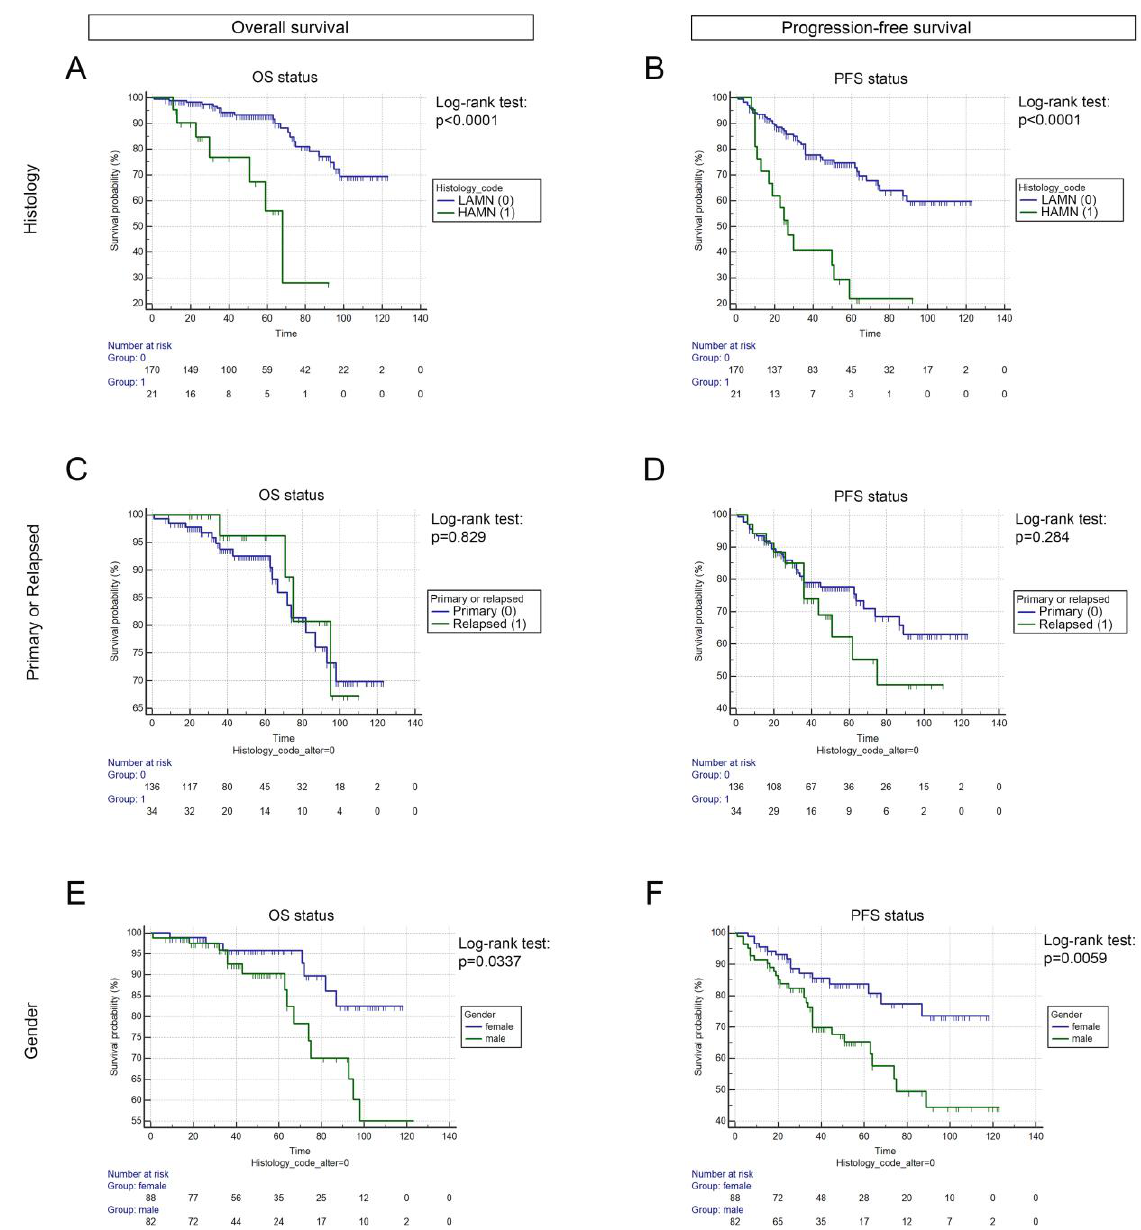
Figure 1. Survival analysis according to histology, tumor type, and gender. According to histology, LAMN patients (vs HAMN patients) showed significantly improved OS (106.45 vs. 61.15 months, p < 0.0001, ( A ) and PFS (90.63 vs. 40.52 months, p < 0.0001), ( B )). There was no significant difference neither regarding OS (105.92 vs. 99.42 months, p = 0.8290, ( C ) nor PFS (93.23 vs. 74.22 months, p = 0.2840), ( D )) between patients with primary vs. relapsed LAMN tumors. Female LAMN patients exhibited significantly improved OS and PFS compared to male patients (OS: 110.47 vs. 96.08 months, p = 0.0337, ( E ); PFS: 99.41 vs. 76.51 months, p = 0.0059, ( F )). Months for OS and PFS are described as means.